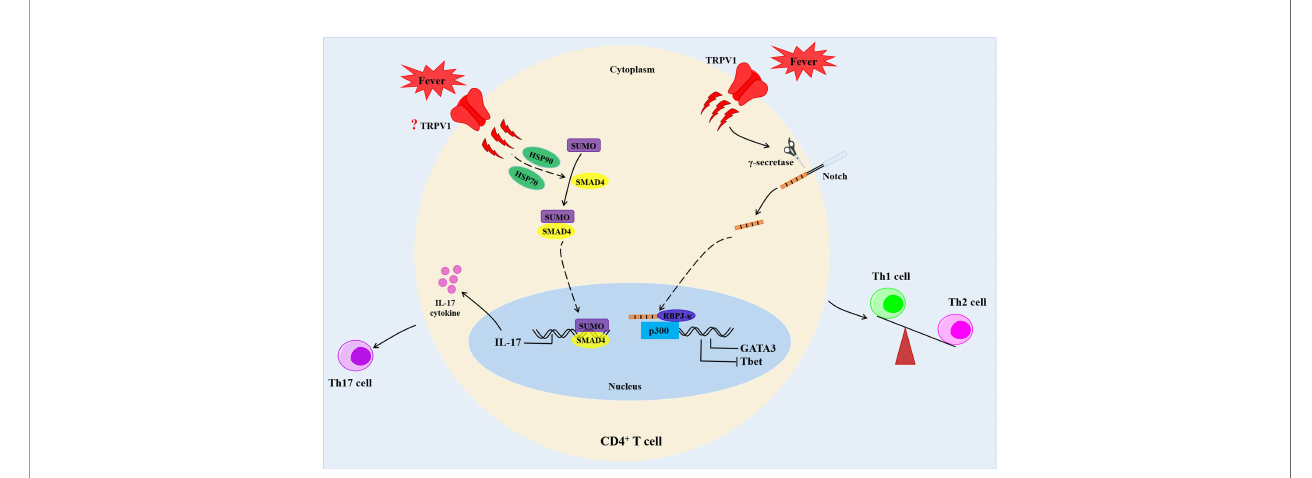
FIGURE 3 | Fever determines the fate of CD4 + T cells. Febrile temperature changes enhance Th2 differentiation and reduce Th1 differentiation via a TRPV1-regulated Notch-dependent pathway. In addition, febrile temperature promotes Th17 cell differentiation which depends on HSP-70- and HSP-90-related heat shock response and enhances SUMOylation of SMAD4 transcription factor at its K113 and K159 residues. HSP90, heat shock proteins 90; HSP70, heat shock proteins